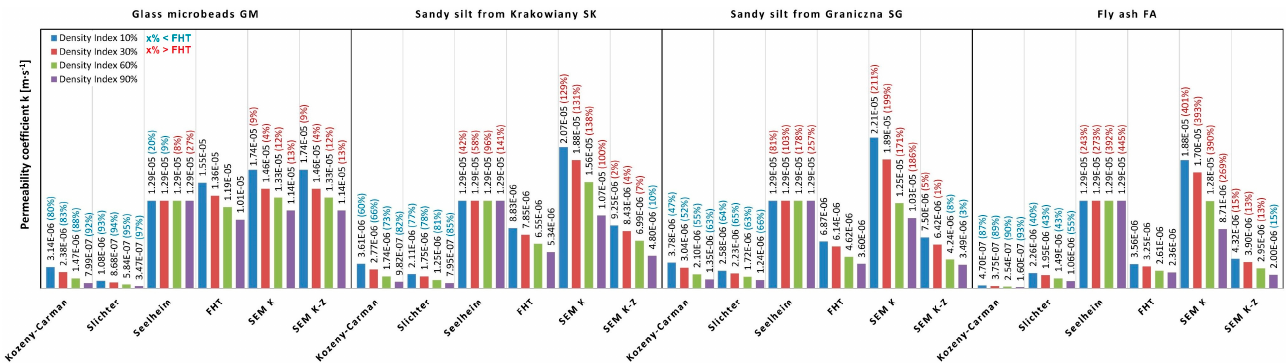
Figure 7. The values of permeability coefficient k obtained with different methods for different soils in relation to